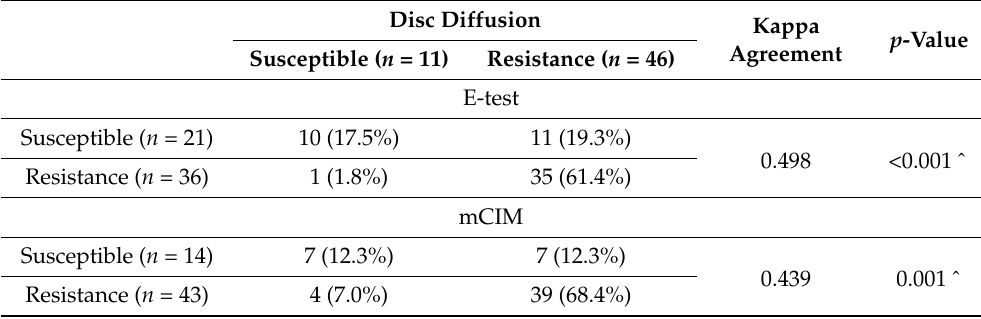
Table 3. Correlation between results of phenotypic tests (disc diffusion, E-test and mCIM) for